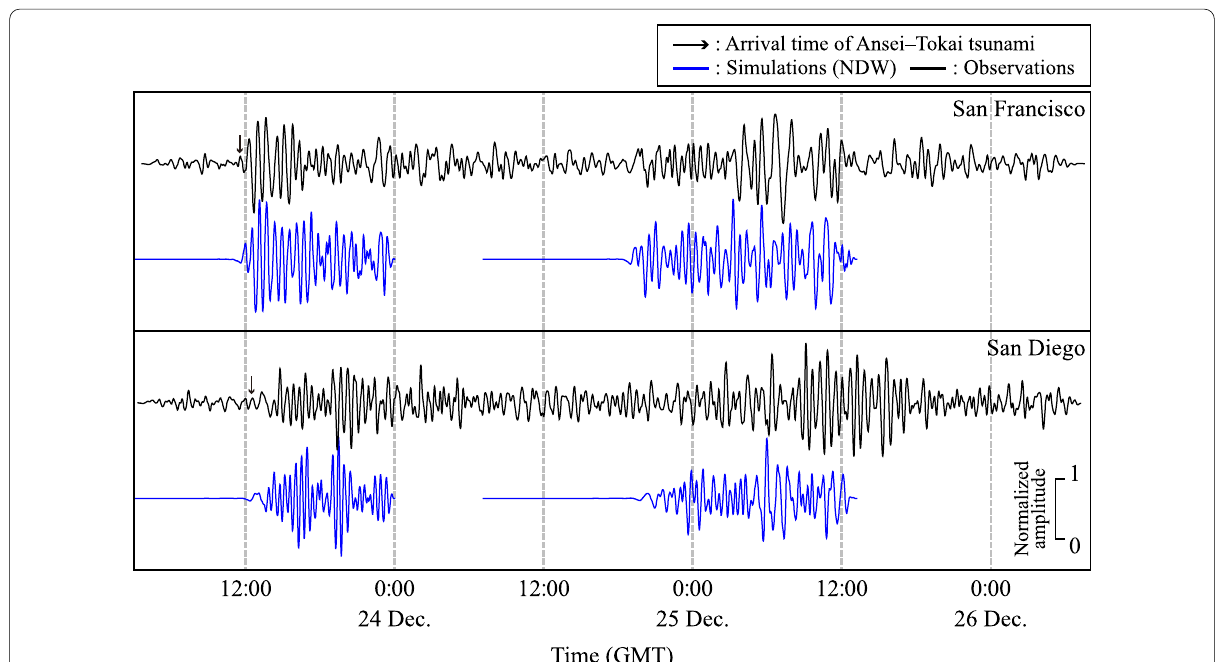
Fig. 4 Comparison of observations and nonlinear dispersive wave (NDW) simulation results for the San Francisco and San Diego tide gauge stations. Black and blue curves show the observed and simulated waveforms, respectively, after application of low- and high-bandpass filters with cut-off periods of 16 and 128 min,